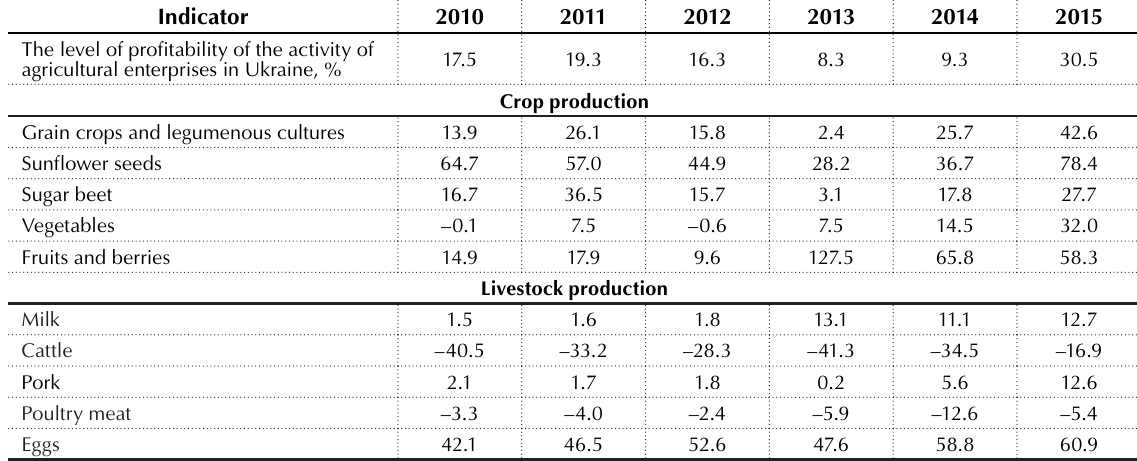
Table 2. Profitability of agricultural production in agrarian enterprises of Ukraine, %